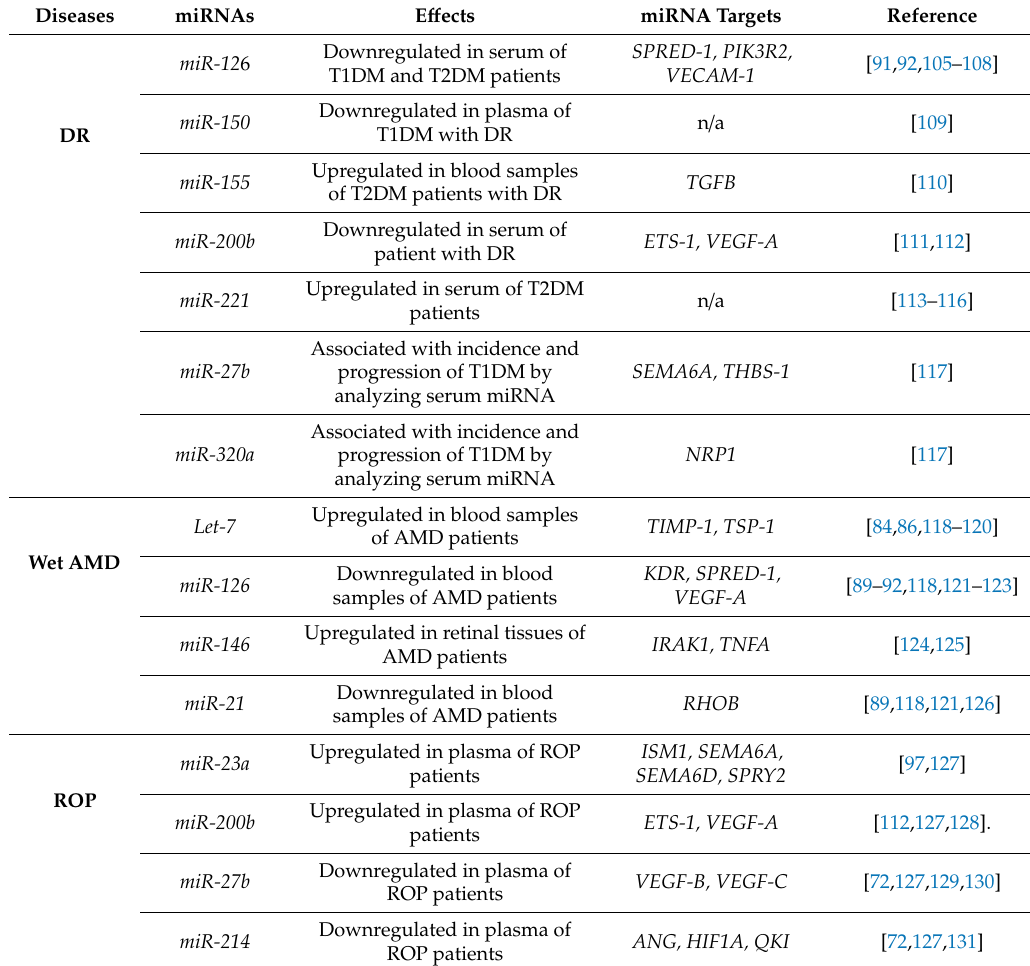
Table 1. Selected miRNAs associated with DR, wet AMD, and